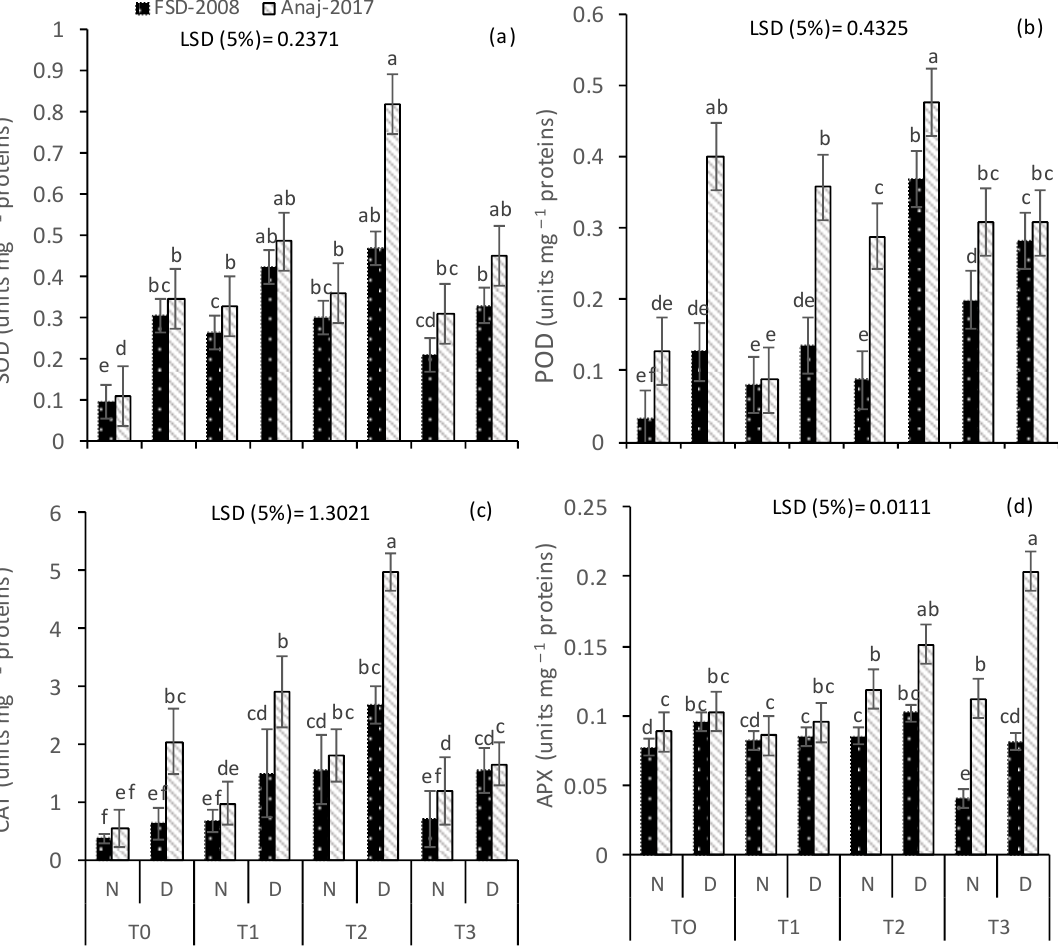
Figure 5. Effects of laser seed priming on ( a ) SOD, ( b ) POD, ( c ) CAT and ( d ) APX in wheat under drought stress . Legend: N = Control (100% field capacity), D = Drought (50% field capacity), T0 = Unprimed control, T1 = 1 min laser priming, T2 = 2 min laser priming and T3 = 5 min laser priming. Means sharing same lowercase letters on bars are statistically non−significant at P ≤ 0.05%)